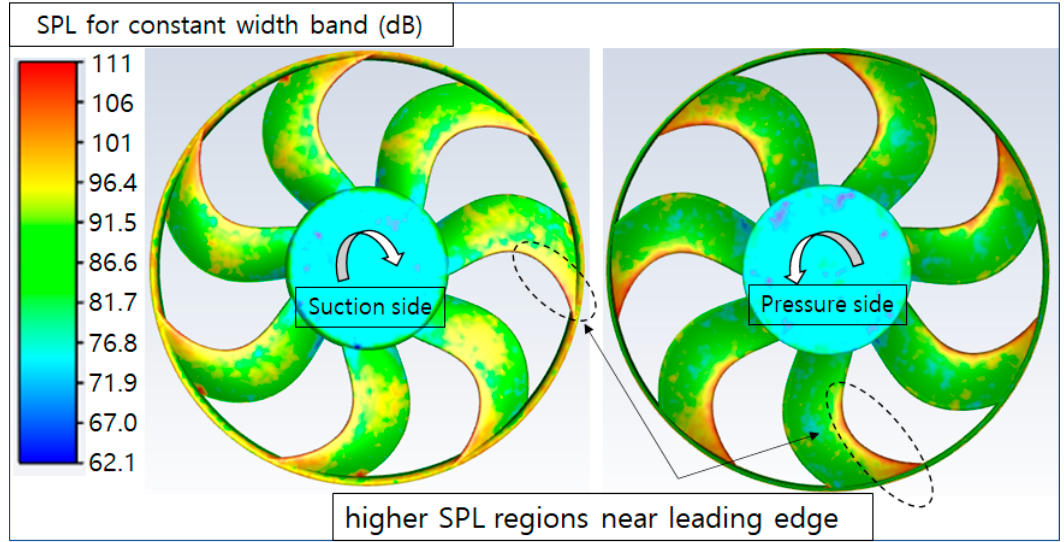
Figure 10. Pressure contours on the pressure side of the fan’s blades an in the wake region at y = 0 section at different dimensionless times of T* = 13.16, 13.19, 13.22, and 13.25.